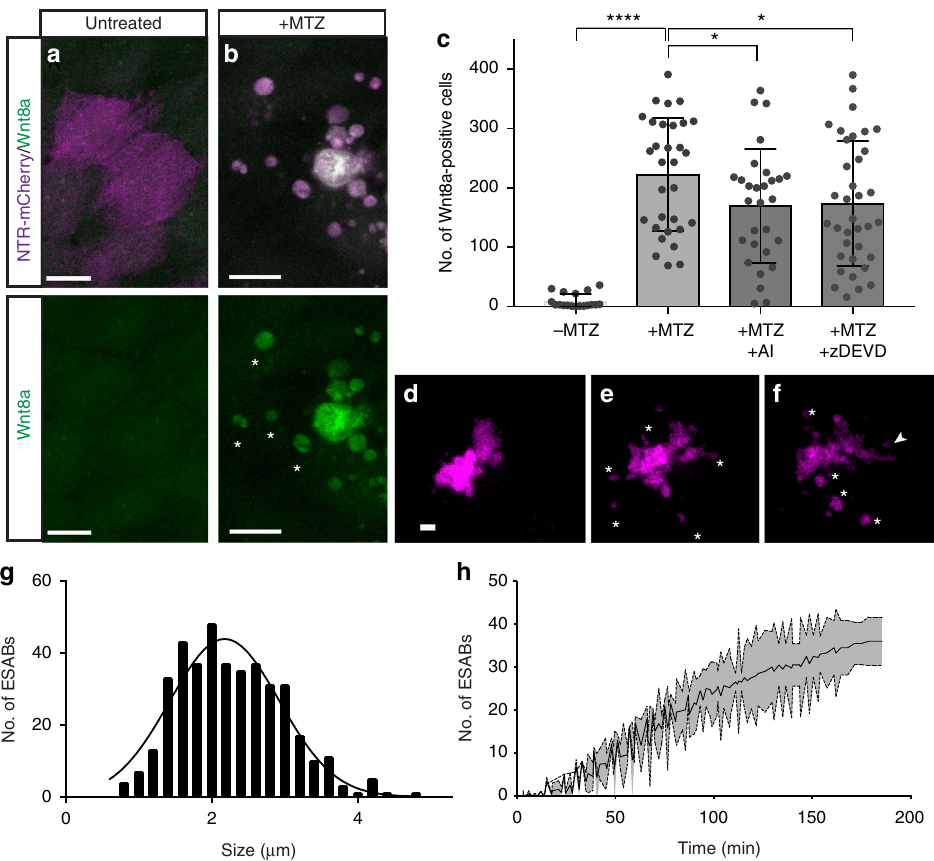
Fig. 2 Caspase-dependent generation of Wnt8a in apoptotic cells and bodies. a , b Maximum intensity projections of confocal images of Wnt8a in healthy and apoptotic stem cells (scale = 10 µ m). c Mean number of Wnt8a-positive cells in individual larvae after induced apoptosis ( n = 31), and in combination with treatment of AI ( n = 29) or zDEVD ( n = 36). Data are from three independent experiments and error bars represent sd. d – f Still images from time- lapse microscopy of an individual apoptotic cell over time (scale = 5 µ m), asterisks mark apoptotic bodies and arrowheads mark fi lopodia extensions (see Supplementary Movie 1). g Size distribution of epithelial stem cell-derived apoptotic bodies. h Quanti fi cation of the production of apoptotic bodies from individual cells. Data from at least three independent experiments are represented as mean ± sd. **** p < 0.0001, * p < 0.03, One-way analysis of variance (ANOVA) with Holm – Sidak multiple comparisons test ( c